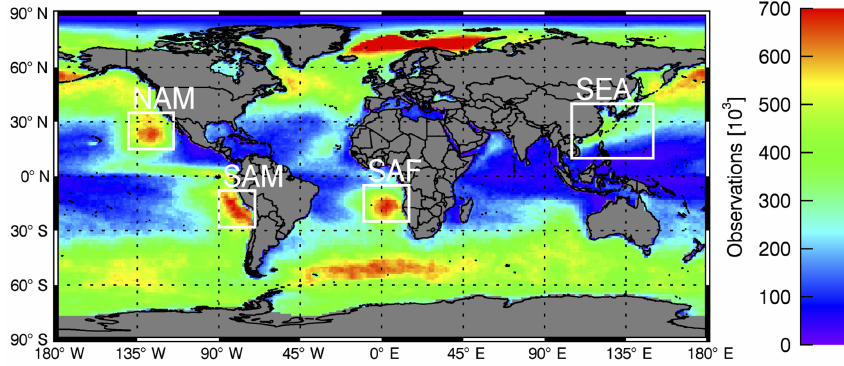
Figure 1. Annual total of Aqua–MODIS liquid phase cloud observations where all three effective radii retrievals are valid per 1 × 1 ◦ grid box. Focus regions are